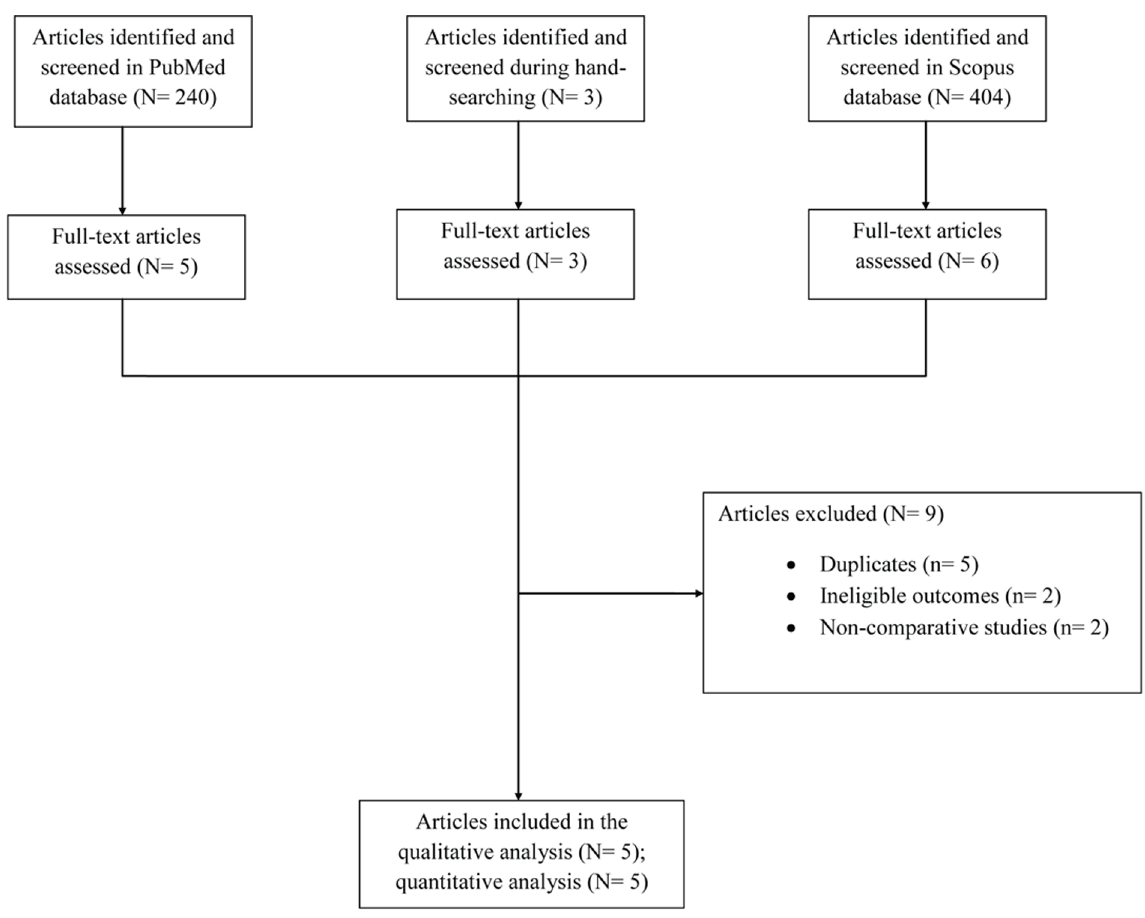
Figure 1. Flow diagram of the detailed study selection process.